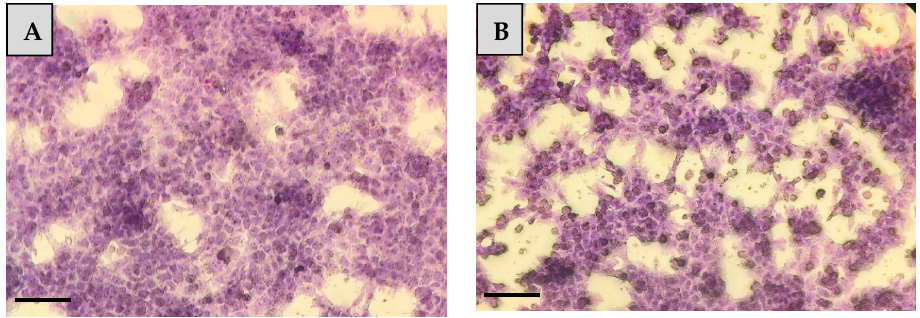
Figure 1. Giemsa staining of (A) hepatocyte mono-cultures and (B) hepatocyte—nonparenchymal cell co-cultures after 48 h culturing (20× magnification, bar = 100 µm).